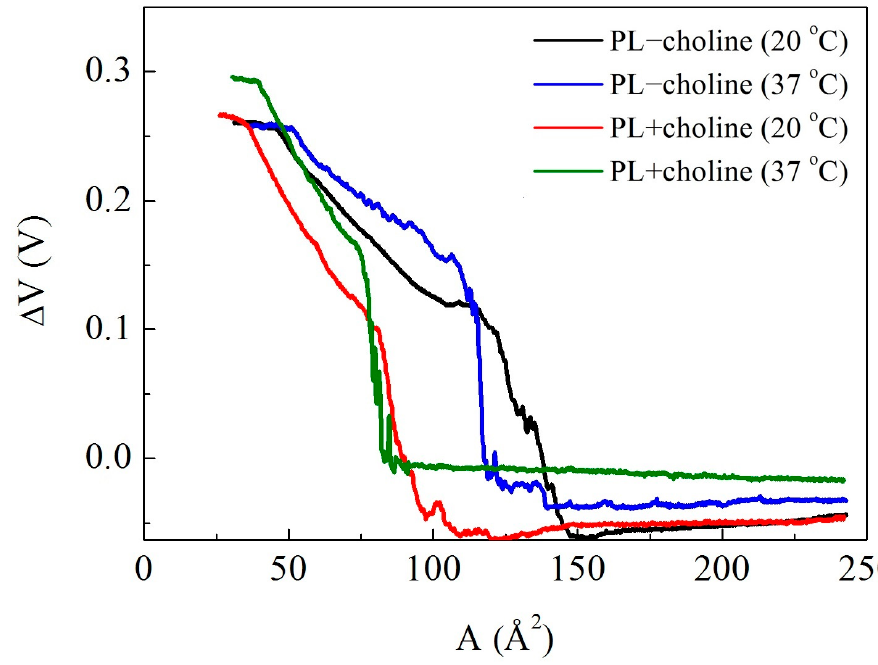
Figure 3. Surface potential changes ∆ V vs. the mean molecular area (A) for the PL − choline and PL+choline monolayers at 20 °C and 37 °C.